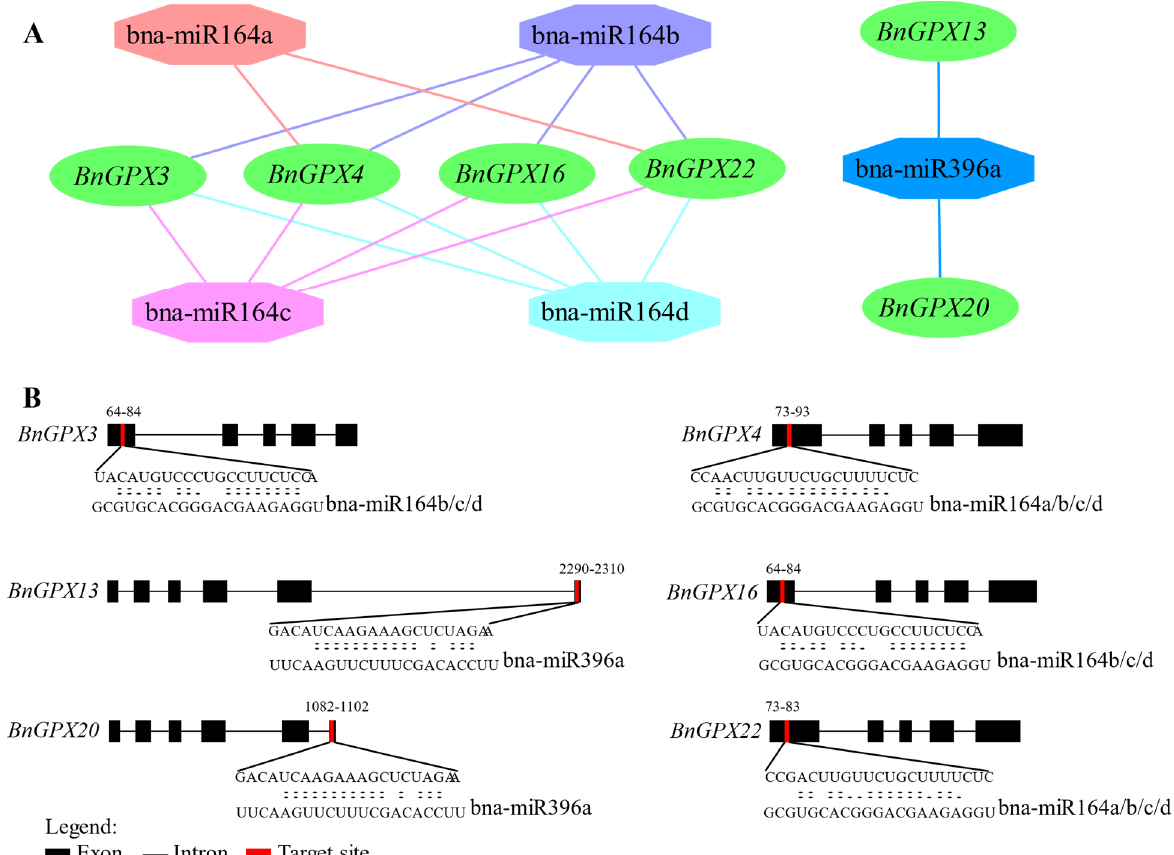
Figure 6. miRNA targeting BnGPX genes. ( A ) Network diagram of predicted miRNA targeting BnGPX genes. The green ellipse colors represent BnGPXs genes, and different color shapes signify miRNAs. ( B ) The graphic illustration signifies the BnGPXs gene targeted by miRNAs. The RNA sequence of each complementary site from 5′-3′ and the predicted miRNA sequence from 3′-5′ are visible in the long-drawn-out areas. See Table S6 for the comprehensive data of all predicted miRNAs.